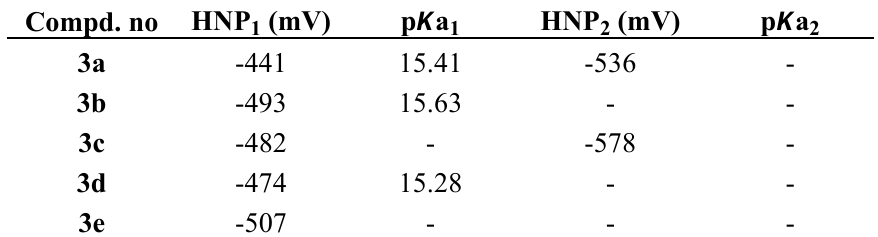
The half-neutralization potentials (HNP) and the corresponding p K compounds 3a-3e in acetonitrile at 25 °C.